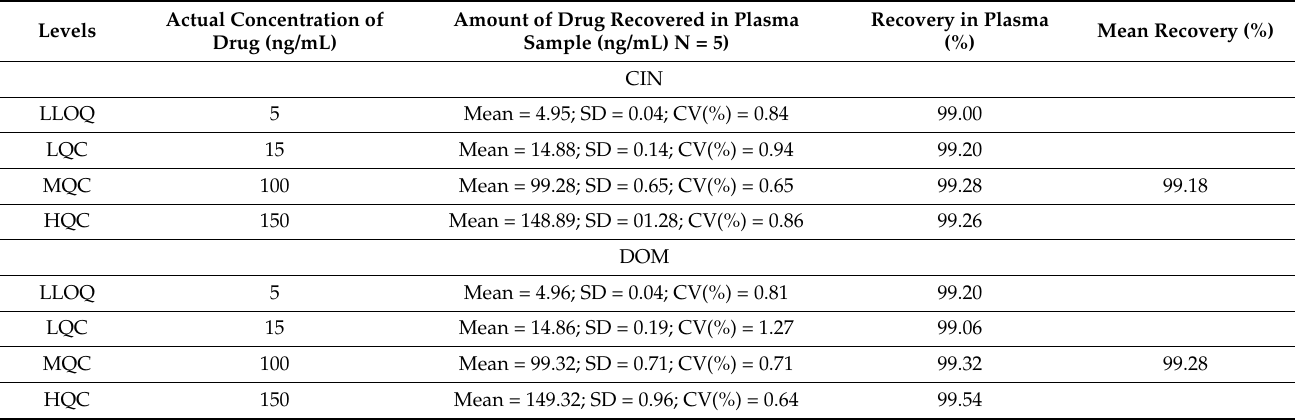
Table 1. Results of accuracy studies for CIN and DOM.